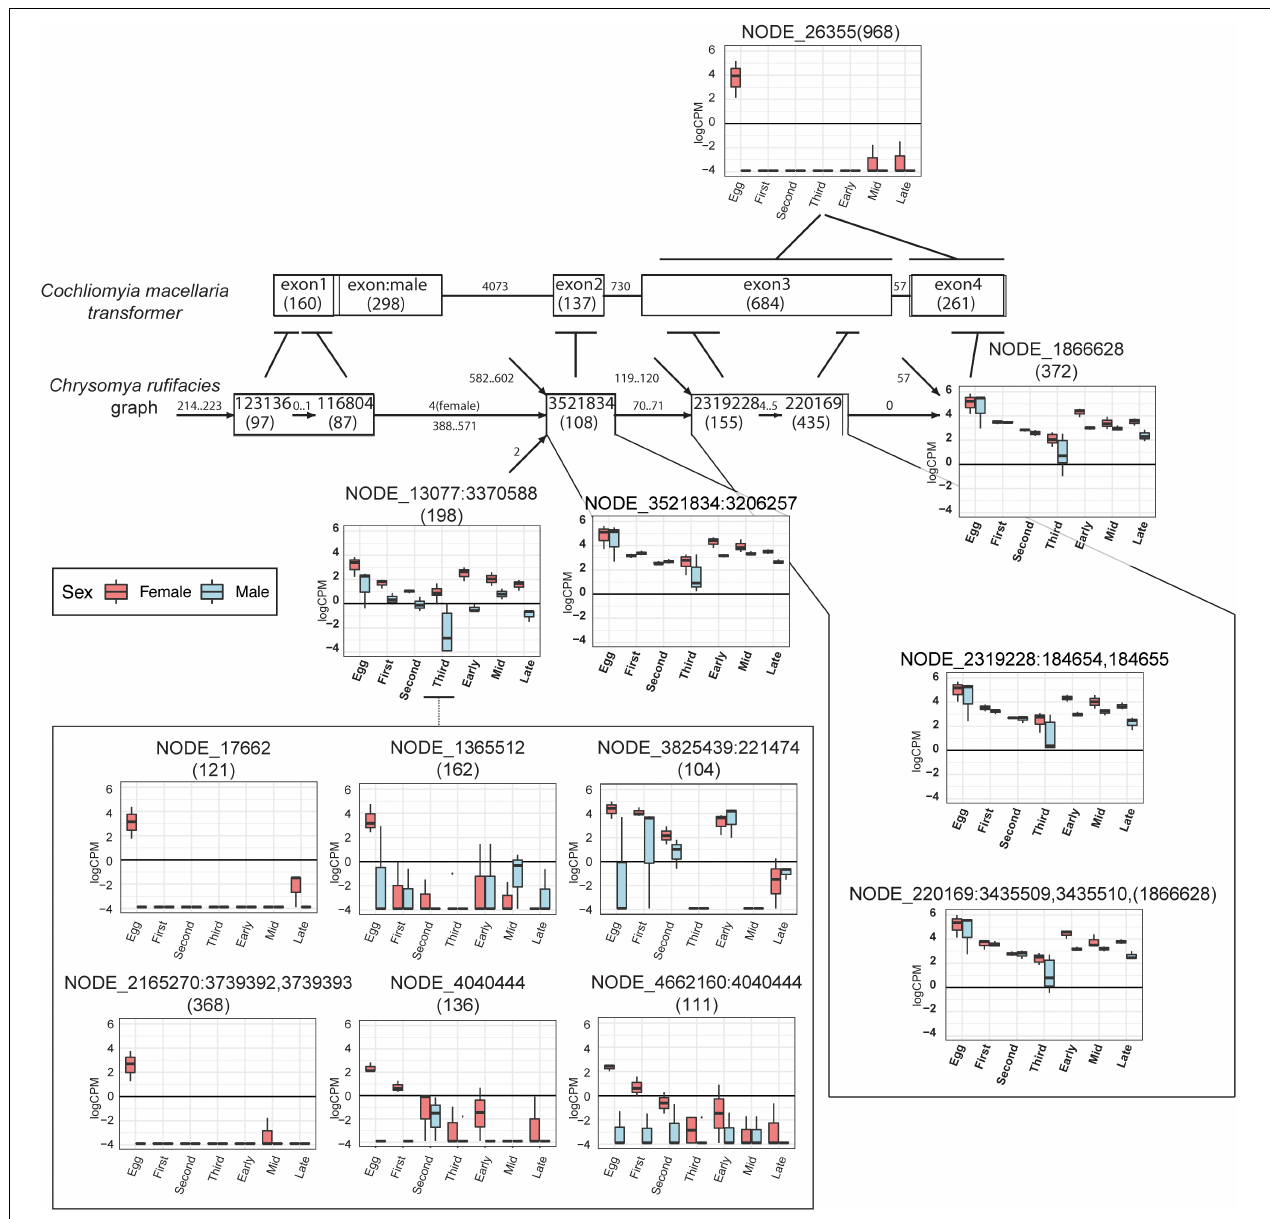
FIGURE 7 | Putative transformer nodes have sex- and stage- specific patterns of expression. Condensed splicing graph in 31_100 assembly of C. rufifacies containing nodes that have hits to the Co. macellaria transformer protein from translated BLAST. Also shown are upregulated nodes in C. rufifacies that have similarity and the Co. macellaria transformer gene model from accession JX315619. Within the Co. macellaria transformer gene model, each exon is labeled by the exon number with its length in nucleotides in parentheses. Each edge is labeled by the length of the intron between the exons. Within the C. rufifacies splicing graph, each node is labeled by the node number with its length in nucleotides in parentheses, and expression ( y -axis:log counts-per-million) is plotted on a sex:stage basis ( x -axis) for those nodes with statistically significant patterns of expression. The line leading out from each node indicates the exonic region from the BLAST hit, with the range of the local hit represented by a horizontal line near the exon. Each edge is labeled by the range of path lengths between the